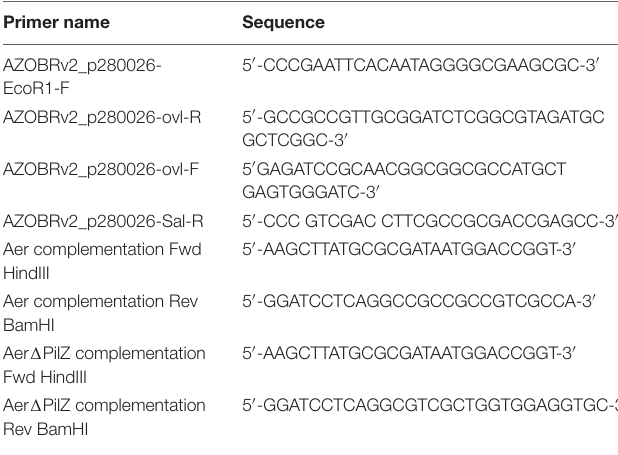
TABLE 2 | Primers used in this